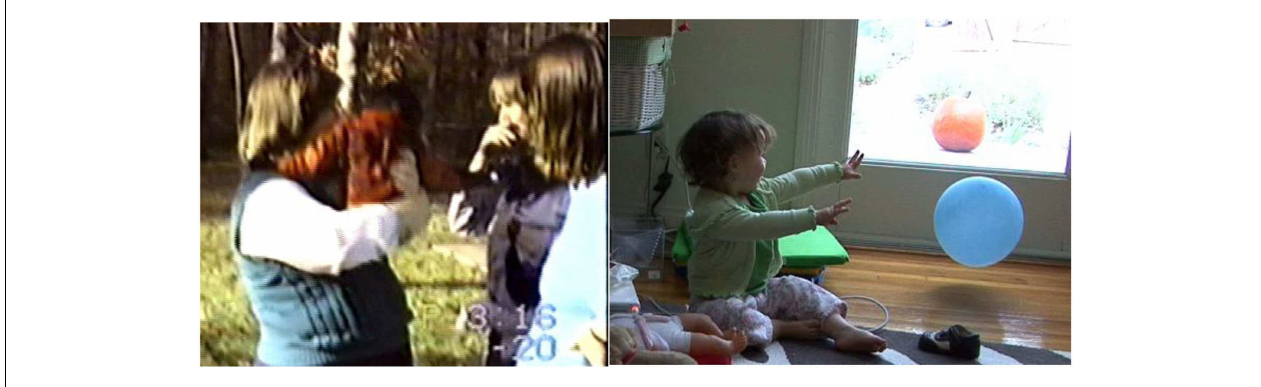
reaches for Sue in this frame. Linda walks away with Panbanisha who vocalizes loudly in protest. Right: human example – Dad throws balloon; GN (15months, 26days) vocalizes and reaches toward it. She turns toward videographer, then dad. “You can go get it,” he says; and she does.